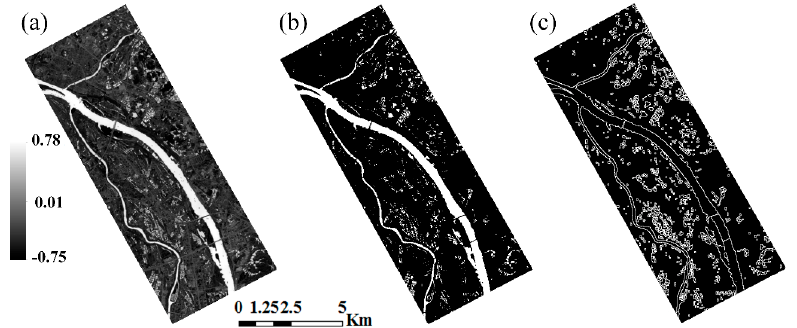
Figure 6. Pure water and mixed water-land pixels for Region D: ( a ) normalized difference water index (NDWI) image of green and SWIR1 bands; ( b ) pure water pixels (white) of NDWI with a 0.053 threshold; and ( c ) mixed water-land pixels (white). Water 2017 , 9 , 658 9 of 17